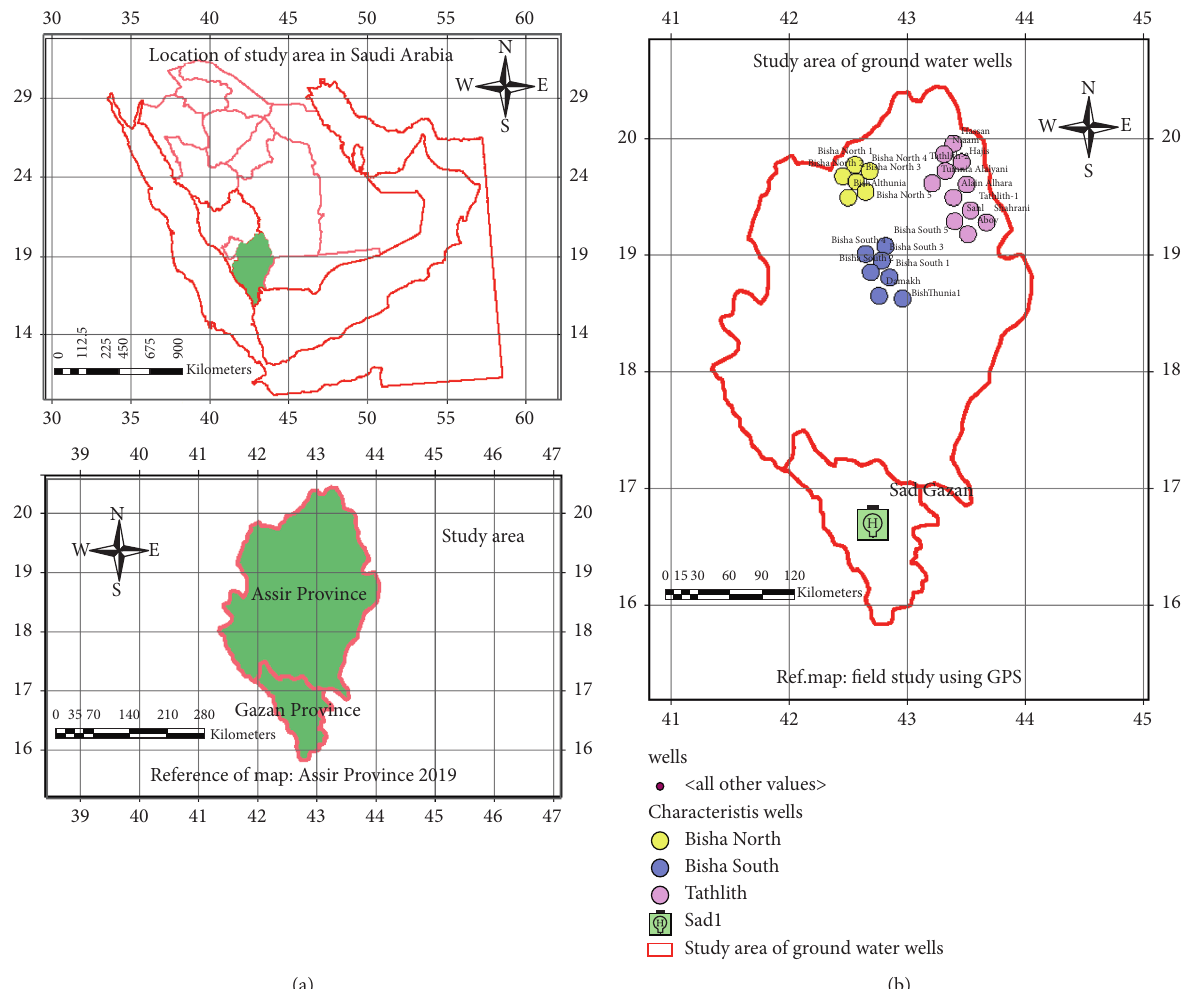
Figure 1: (a) Map of Saudi Arabia including Asir province. (b) Map of Asir province including Bisha region (study area) showing the groundwater sampling